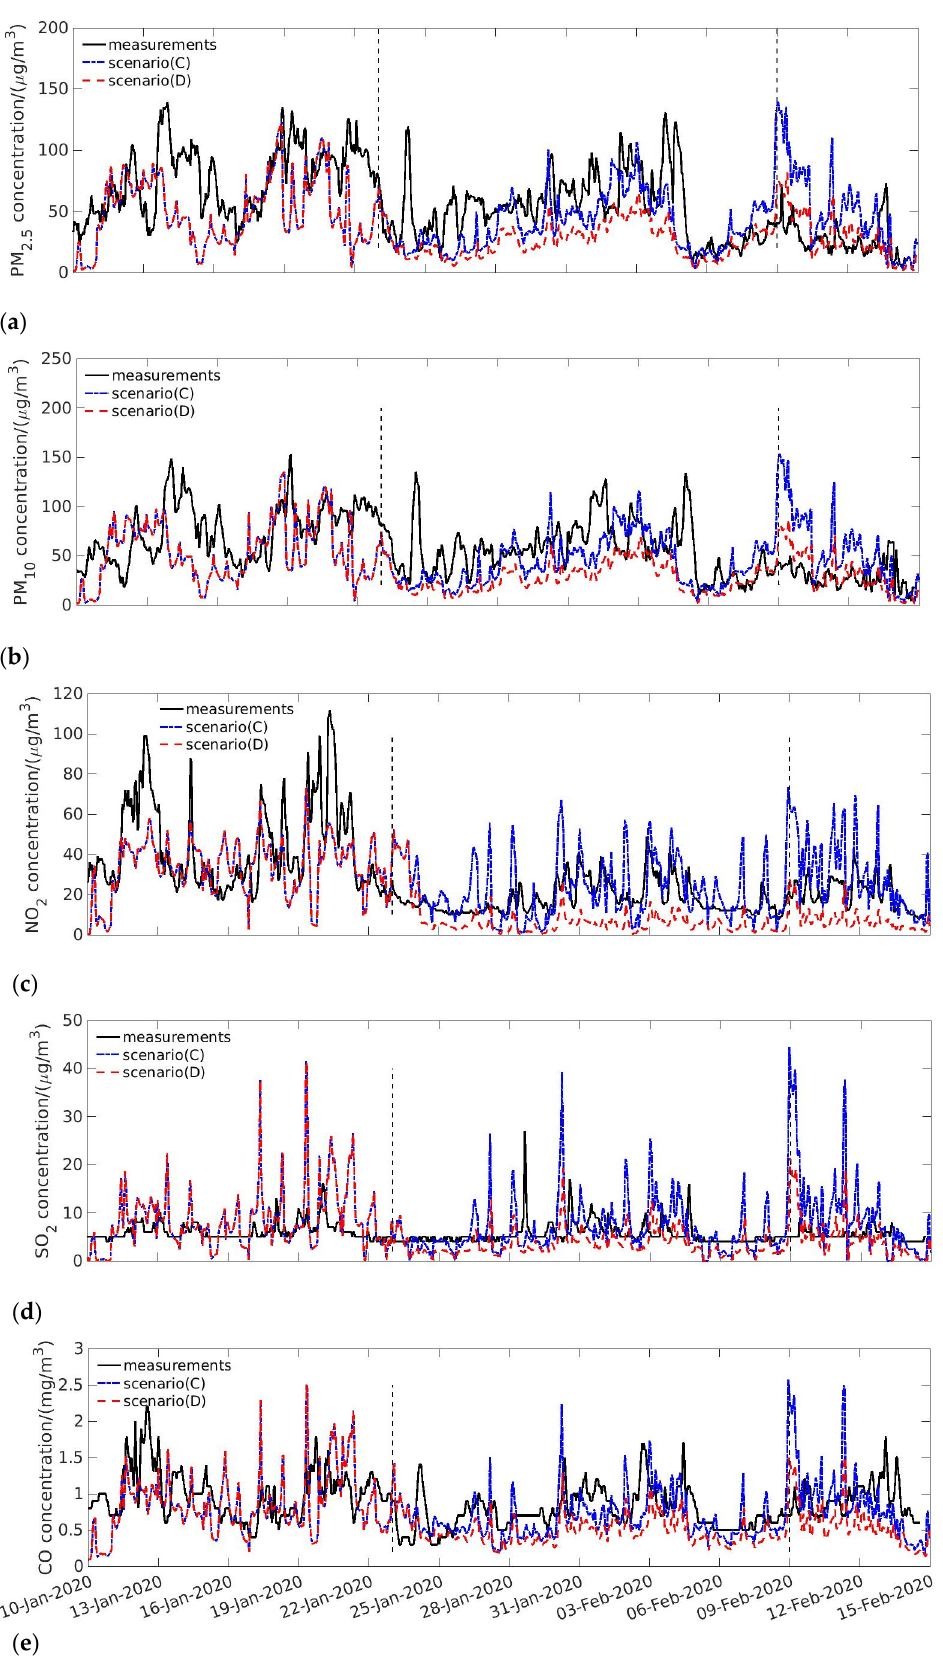
Figure 6. Pollutant concentration influenced by the transportation and industry emissions. Each panel shows comparison of observations and simulation results of scenarios (C) and (D) for ( a ) PM 2.5 , ( b ) PM 10 , ( c ) NO 2 , ( d ) SO 2 , and ( e ) CO. ( b ) PM 10 , ( c ) NO 2 , ( d ) SO 2 , and ( e )